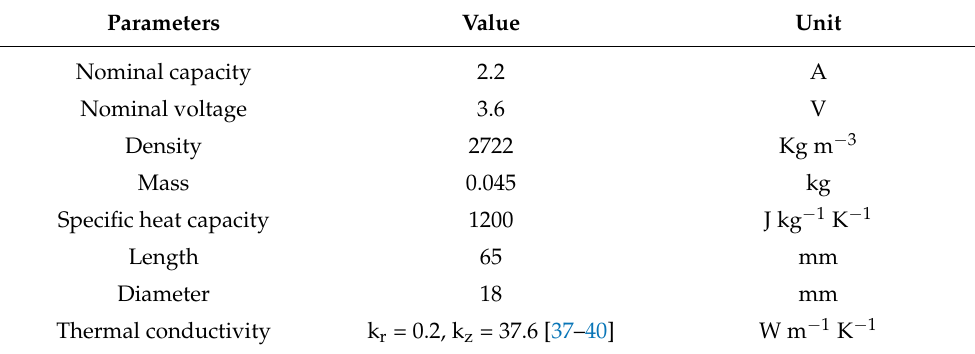
Table 1. The important physical features of the cell in the battery module are adapted from [36].